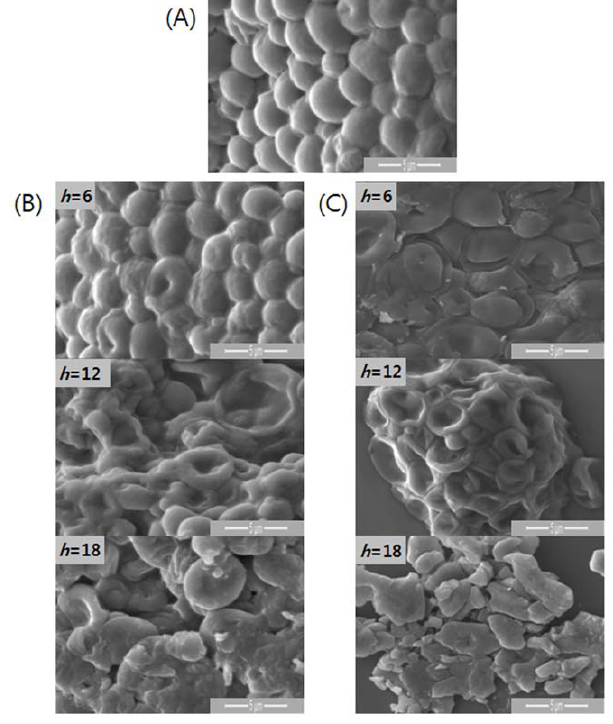
Figure 2. SEM images of C. albicans cells. A is the image of untreated cell. B and C show images cells treated with flucytosine (A) and amphotericin B (B) for h =6, 12, and 18, respectively.